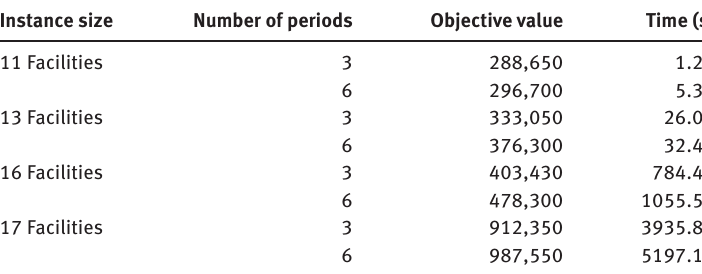
Table 5: Obtained Results for AOTLP Using MILP Model.